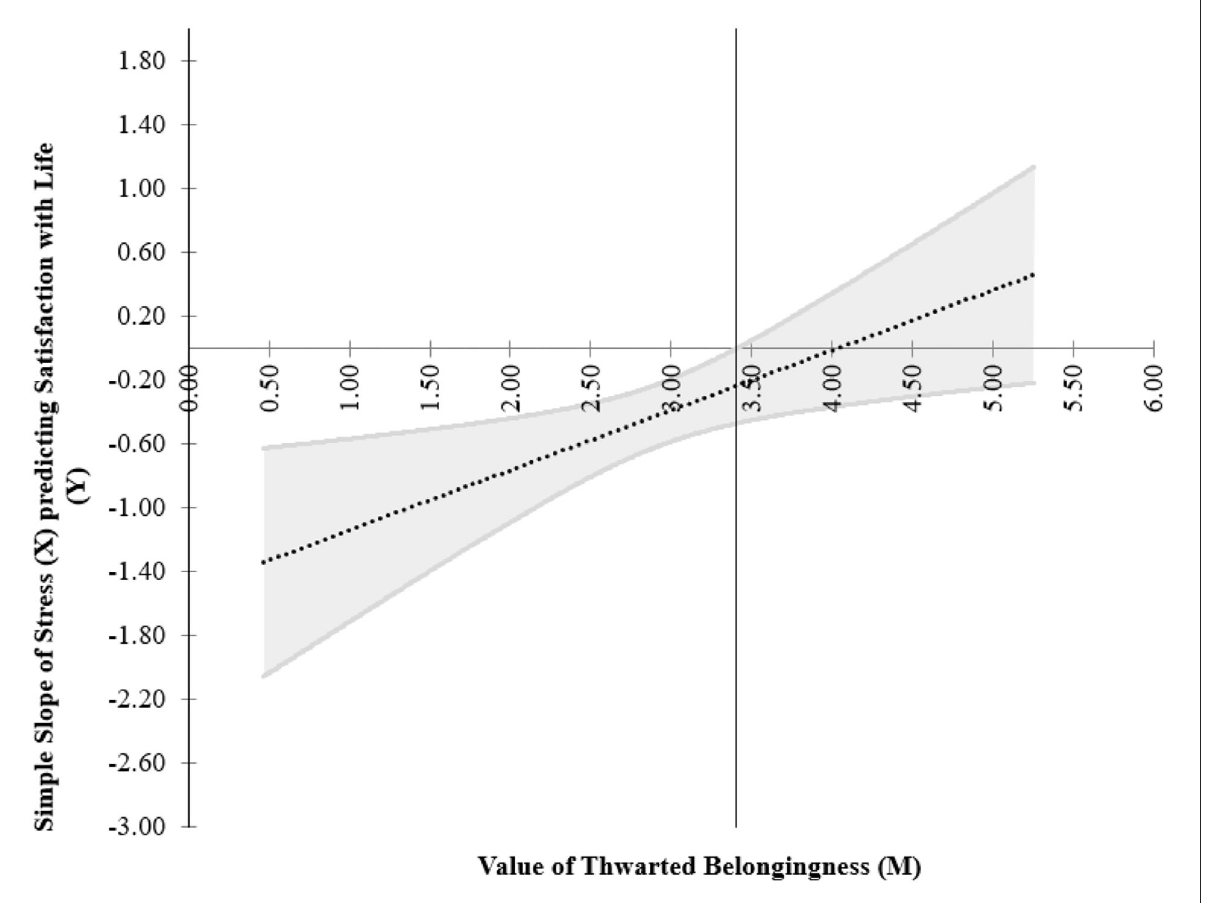
FIGURE6 Johnson–Neyman regions representing the threshold for significant of the effects of focal predictor (stress) on the outcome variable (satisfaction with life) for different levels of moderator (thwarted